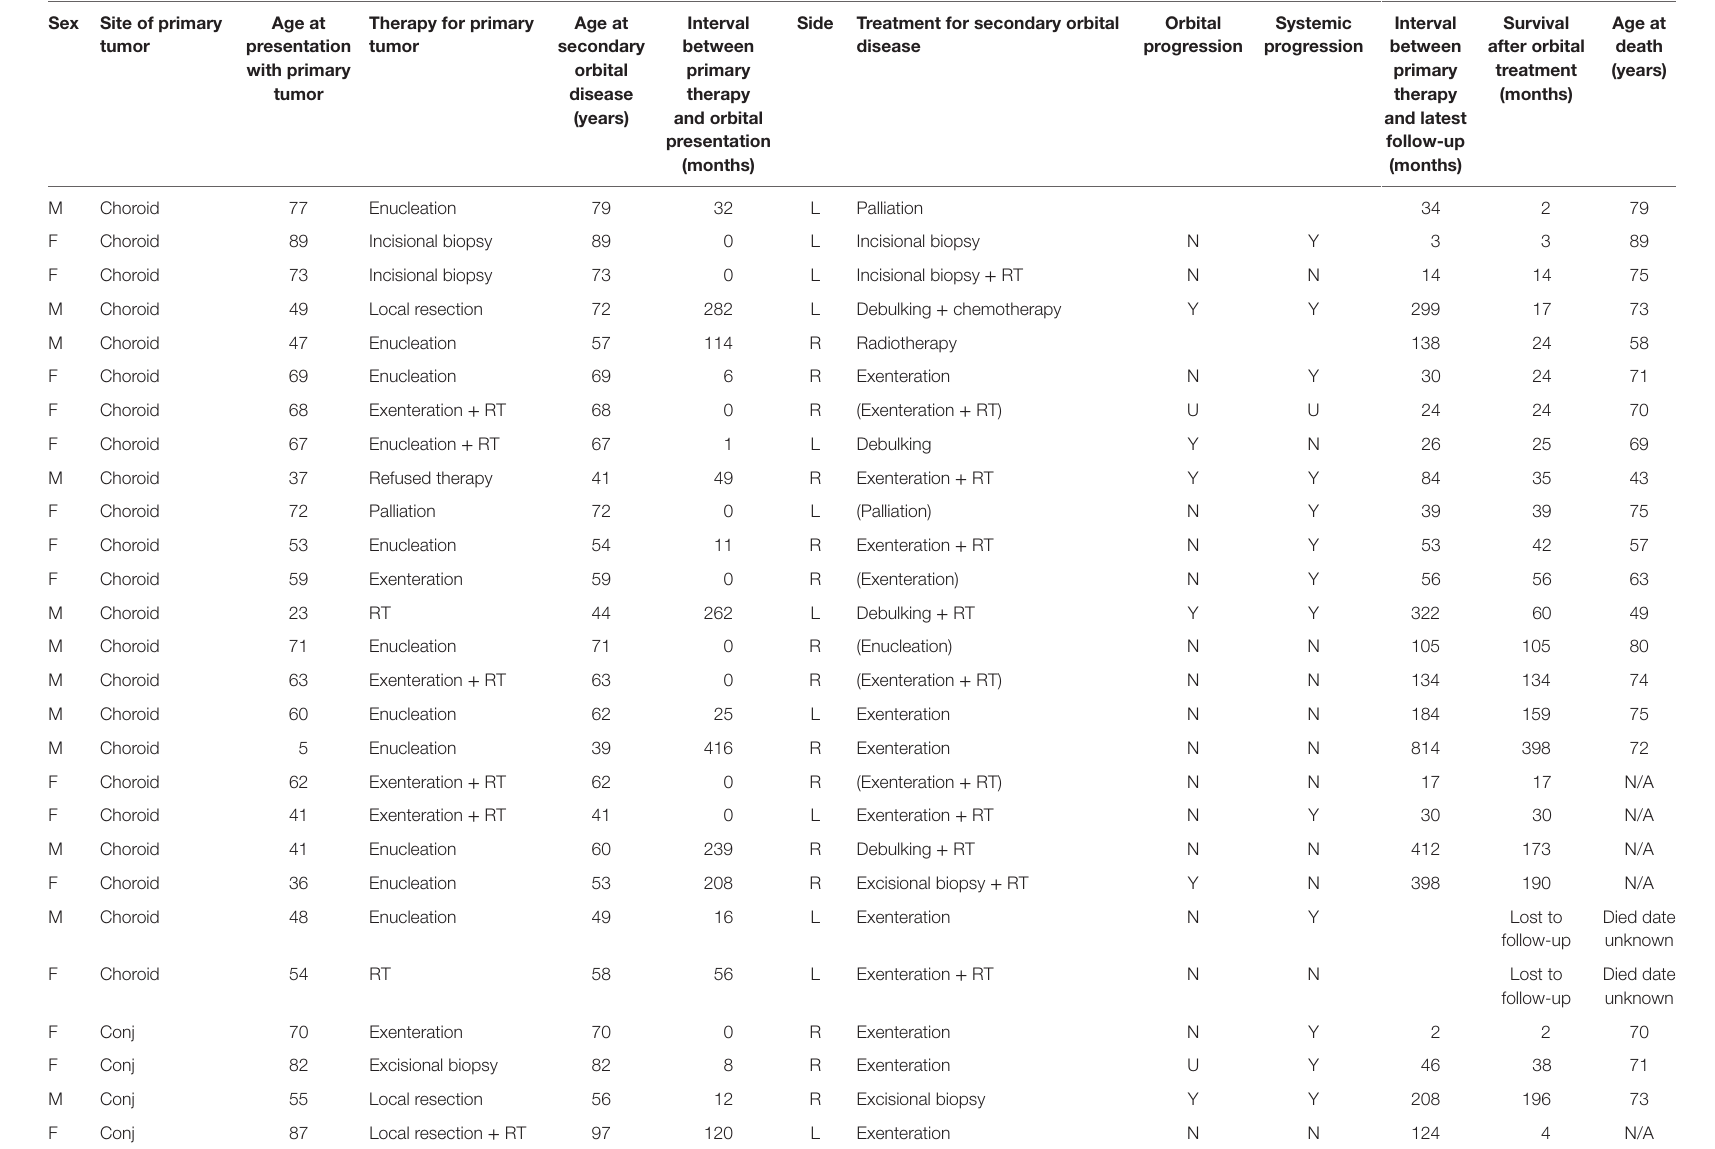
TaBle 1 | Clinical characteristics of 48 patients with orbital malignant melanoma secondary to a primary tumor elsewhere, classified by the site of primary tumor and the survival interval after presentation with orbital disease. sex site of primary